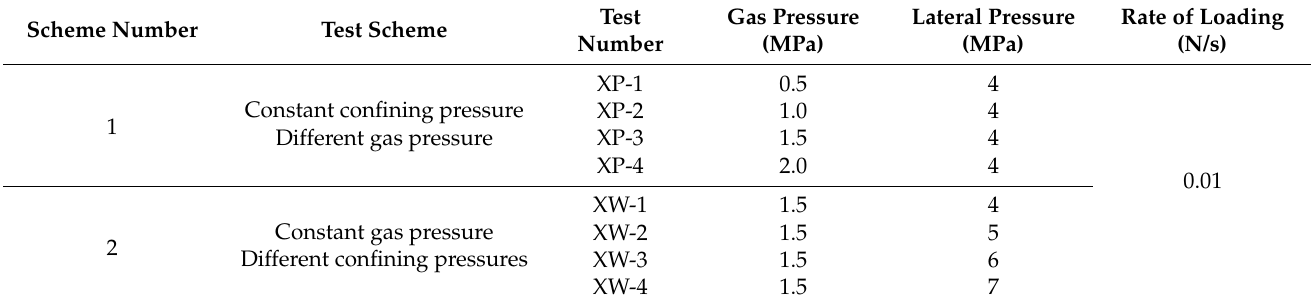
Table 2. Loading test scheme.